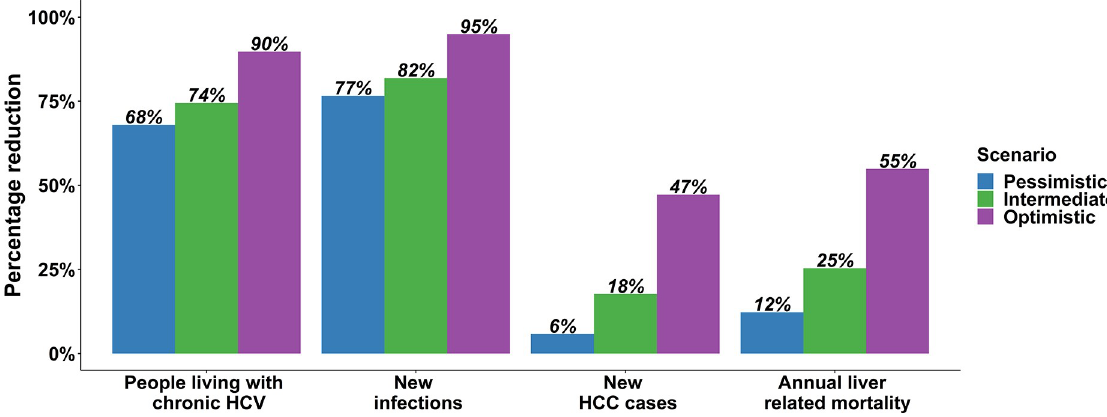
Fig 3. Percentage reductions in PLHCV, new infections, new HCC cases (viraemic and cured), liver-related mortality (viraemic and cured), in 2030 compared to 2015 (blue bar: Pessimistic scenario, green bar: Intermediate scenario, purple bar: Optimistic